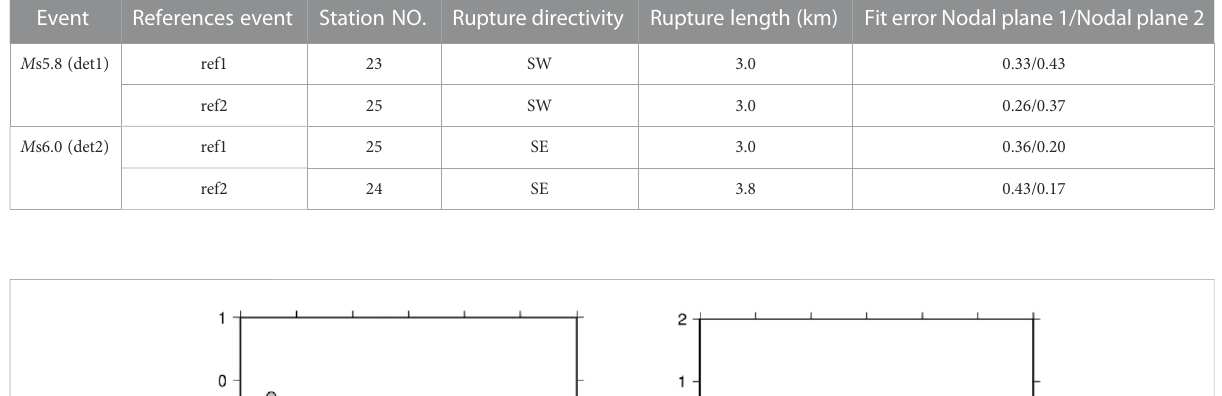
TABLE 4 Rupture directivity of the M s5.8 (det1) and M s6.0 (det2) events.